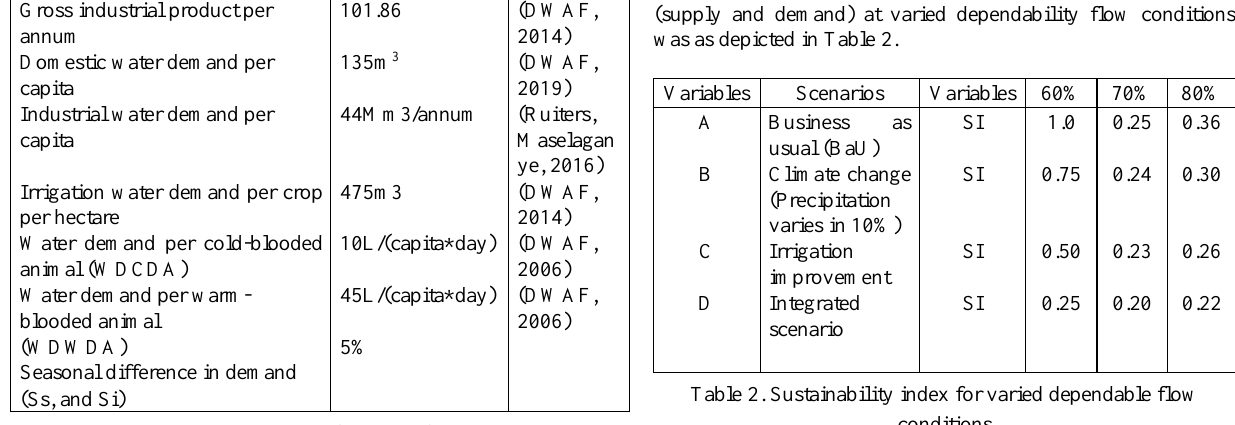
Table 1. Parameters value used for each of the riparian water demands and supply